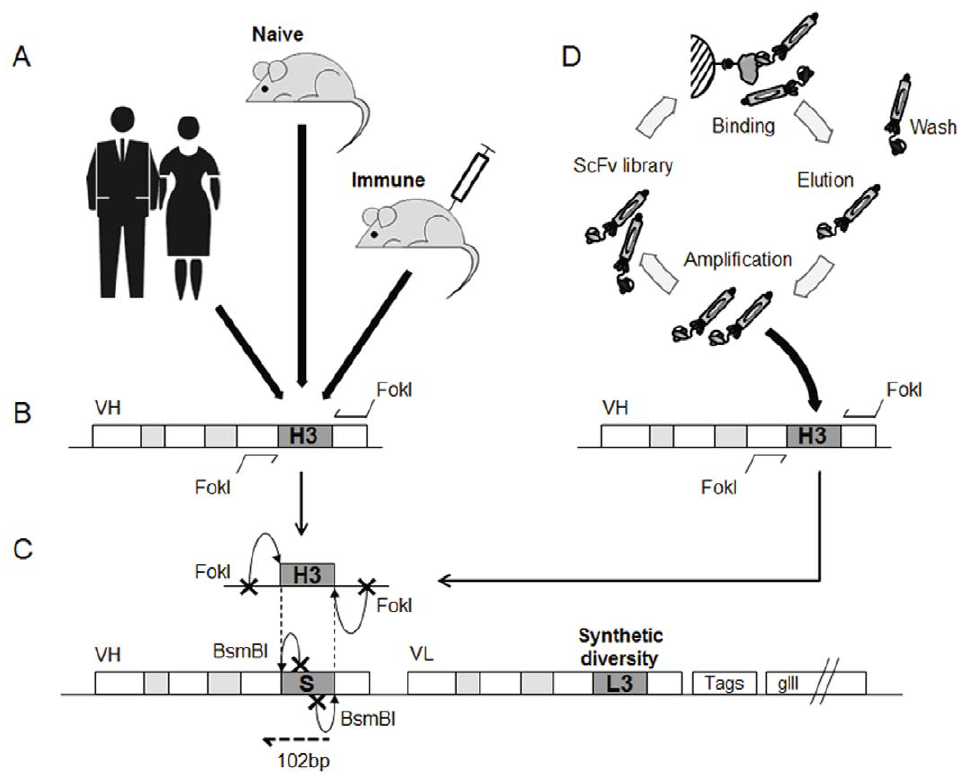
Figure 1. Strategy for capturing CDRH3 diversity into a human antibody library. (A) Natural diversity was incorporated from naive human donors and BalbC mice either kept naive or immunized with hIFN c or hCCL5. (B) Their CDRH3 repertoires were extracted and amplified by PCR. During this step, recognition sites for the type IIS enzyme FokI were added. CDR3 are represented in dark grey, CDR1 and 2 in light grey. (C) Following digestion by FokI, repertoires of CDRH3 were cloned into an acceptor library itself digested with BsmBI. This second type IIS enzyme allowed the removal of a non diversified stuffer sequence (‘‘S’’) at the location of CDRH3 and the generation of compatible cohesive ends for the incorporation of CDRH3. The acceptor library combines 7 human VH and 7 human VL in a format of scFv as well as additional synthetic diversity in the CDRL3 (‘‘L3’’ in the picture). Tags allow for purification while gIII allows for display on phage. After cloning of CDRH3, resulting libraries were analyzed by NGS covering the location of the CDRH3 and part of VH at the 5 9 border (102 bp covered). (D) Similarly, sequences from a library of synthetic CDRH3, SnA, were explored in the context of the human acceptor library. Prior to the amplification, the repertoire of SnA was biased in vitro towards hIFN c by performing three rounds of selection by phage